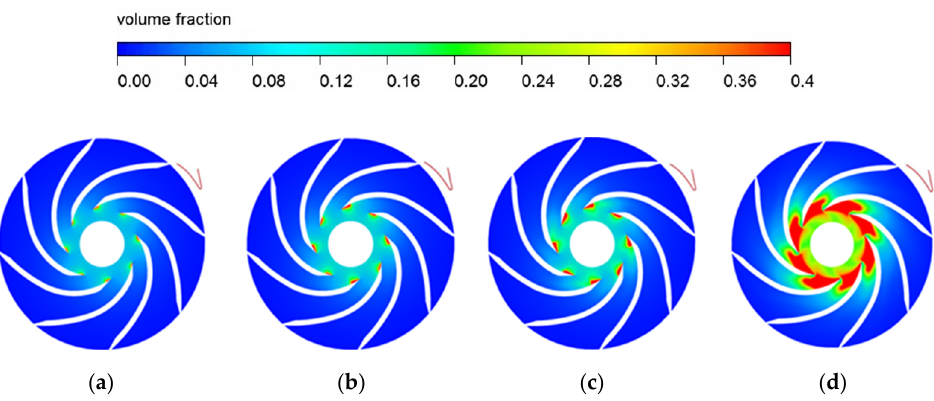
Figure 9. The vapor volume fraction distributions on the middle cross-section of the impeller: ( a ) NPSHa = 1.67 m; ( b ) NPSHa = 1.32 m; ( c ) NPSHa = 1.05 m; ( d ) NPSHa = 0.65 m.